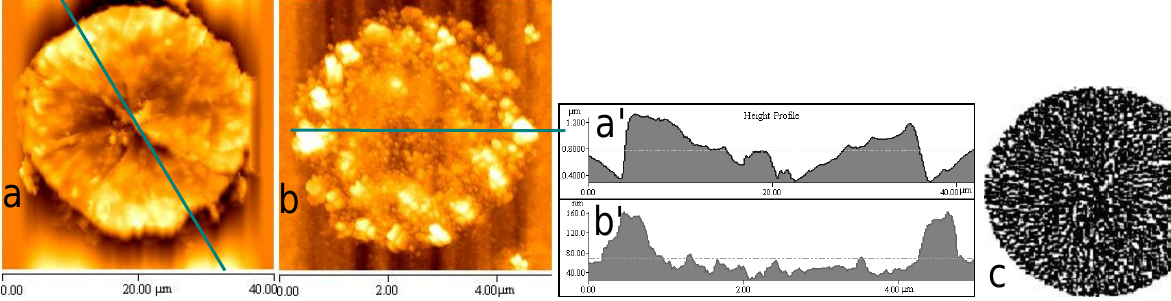
Figure 8. Self-assembly discal structures and height profile of conjugates of Cu (II)-chitosan (a) and Ag (I)-chitosan (b). Figure c is the Eden model of